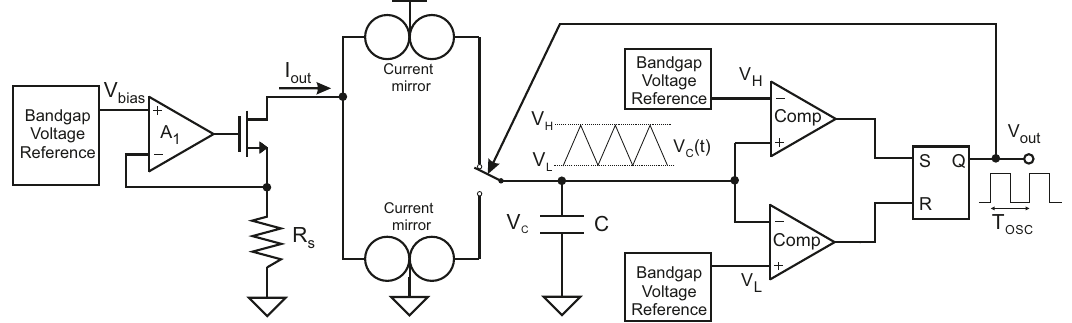
Figure 1. Typical resistance-to-period